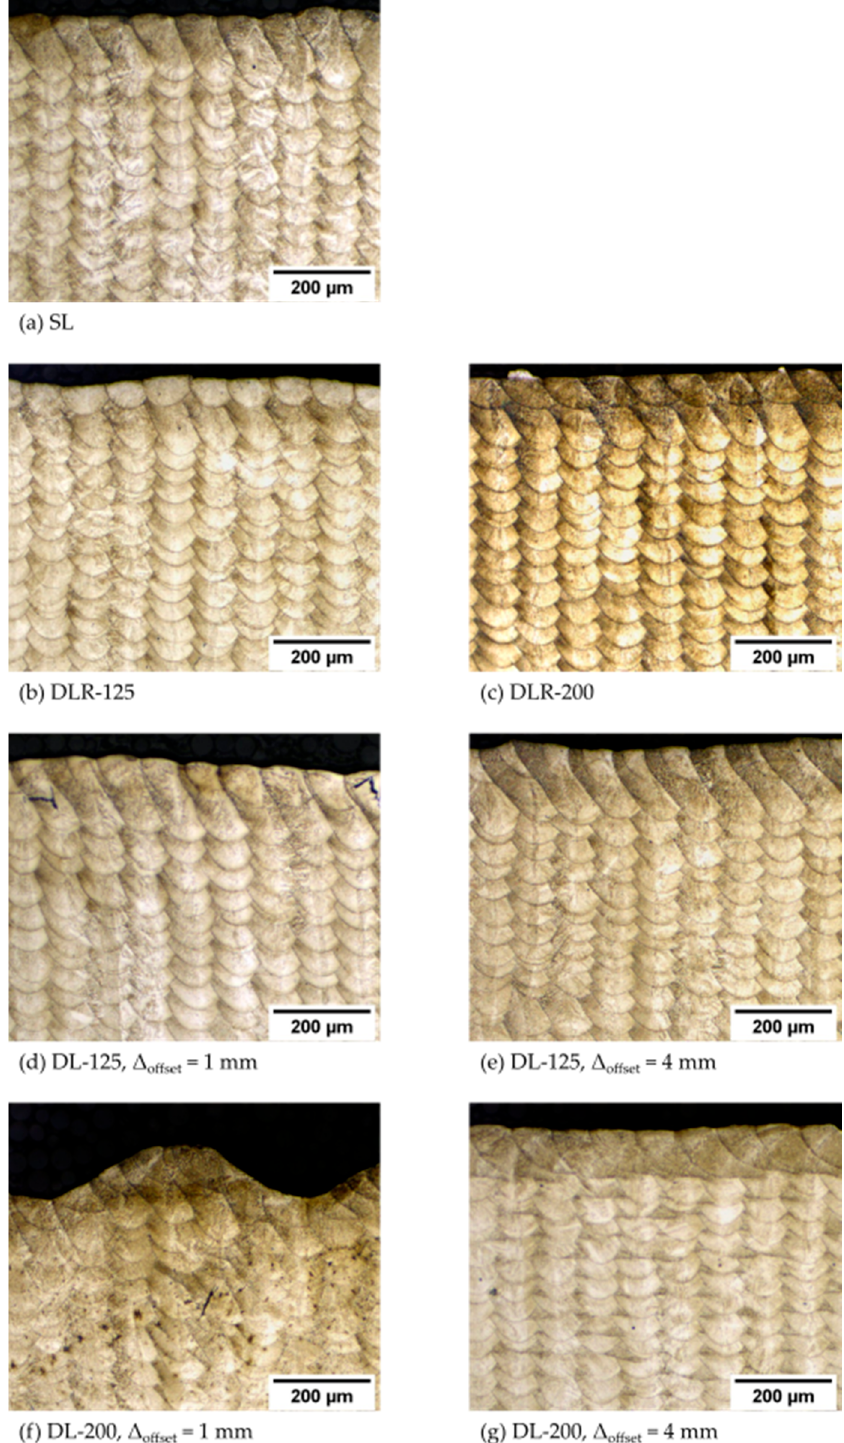
Figure 12. Melt pool cross-sections for measurements of the melt pool dimensions and material structure analysis of the parameter sets ( a ) SL, ( b ) DLR-125, ( c ) DLR-200, ( d ) DL-125 with ∆ offset of 1 mm, ( e ) DL-125 with ∆ offset of 4 mm ( f ) DL-200 with ∆ offset of 1 mm and ( g ) DL-200 with ∆ offset of 4 mm.